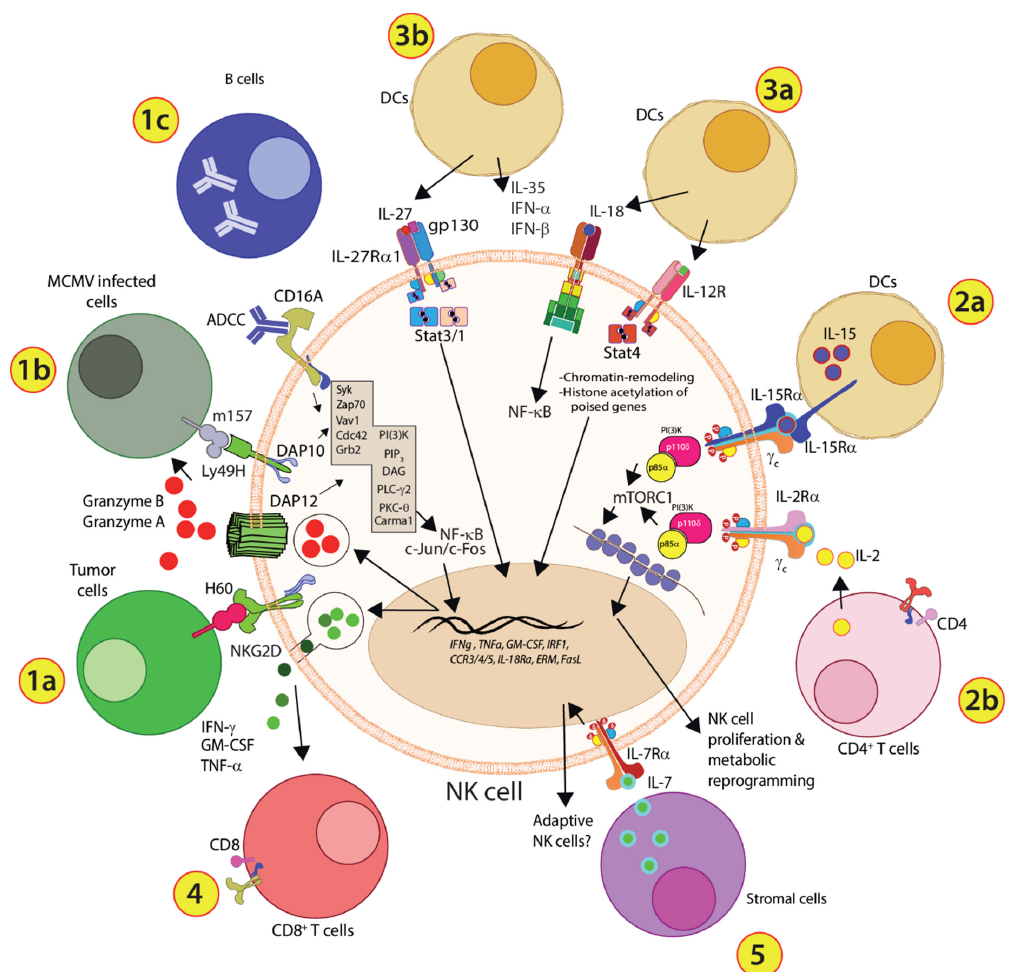
Figure 7. Integrated view of the ‘third signal’ in NK cells. ( 1a ) Recognition of tumor cells via stress ‐ induced ligands, such as H60, provides primary activation via NKG2D in murine NK cells. ( 1b ) Similarly, recognition of viral proteins including MCMV ‐ derived m157 mediates stimulation of murine NK cells via ly49H. These two activation receptors mediate their signals utilizing DAP10 and DAP12. ( 1c ) NK cells also mediate target cell recognition using antibodies bound to its recep ‐ tor CD16a. The downstream signaling cascades lead to cytokine production and cytotoxicity against target cells. ( 2a ) IL ‐ 15 produced by DCs is trans ‐ presented to NK cells to proliferate. ( 2b ) IL ‐ 2 from CD4 + T cells plays a similar role in the expansion of NK cells. However, the context where DCs or CD4 + T cells play this role is yet fully defined. ( 3a ) IL ‐ 12 and IL ‐ 18 generated by DCs can activate NK cells utilizing a distinct signaling cascade. However, this is thought to occur primarily during viral or bacterial infections. The in vivo context where IL ‐ 12 functions, along with NK cell ‐ activating receptors is not known. Irrespective of this, given that Stat4 mediates chromatin remodeling and histone acetylation fol ‐ lowing IL ‐ 12 stimulation indicates that the primary mechanism is to keep the poised genes in the open conformation and, therefore, the parallel stimulation with activating receptors or IL ‐ 18 can promote the production of cytokines or cytotoxi ‐ city associated proteins. ( 3b ) IL ‐ 27 and IL ‐ 35 produced by DCs also activate NK cells. Signaling by Il ‐ 27 is context ‐ depend ‐ ent and can both activate or inhibit the production of IFN ‐ . ( 4 ) NK cells can activate CD8 + T cells via IFN ‐ , GM ‐ CSF, or TNF ‐ . ( 5 ) IL ‐ 7 may play an essential role in promoting NK cells to differentiate into adaptive NK cells. While these findings provide an exciting basis for novel immunotherapeutic ap ‐ proaches, the reasons for their existence and the molecular basis are elusive. Are IL ‐ 12 family cytokines the only ones capable of mediating the ‘third signal’? How is the ‘third signal’ regulated by the developmental rules such as ‘licensing’ or ‘arming’? Do MHC ‐ Class I ‐ KIR interactions inhibit the IL ‐ 12 family ‐ mediated activation of NK cells? Do other